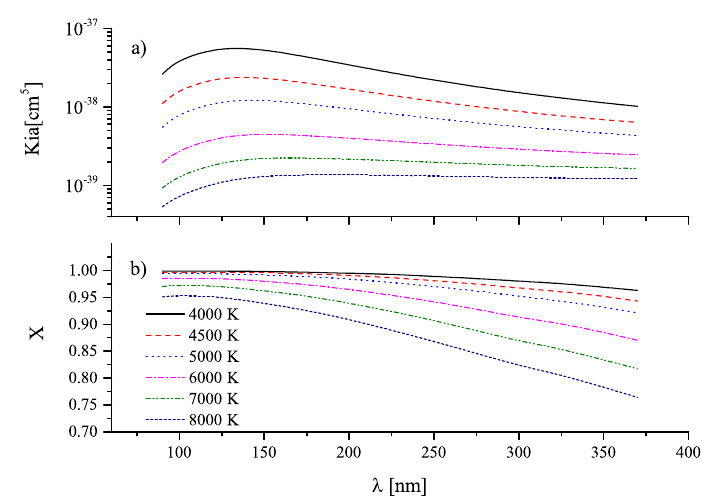
Figure 15. ( a ) the total absorption coefficient Kia as a function of λ and T ; ( b ) the branch coefficient X as a function of λ and T . Calculations from [47] case A = H.